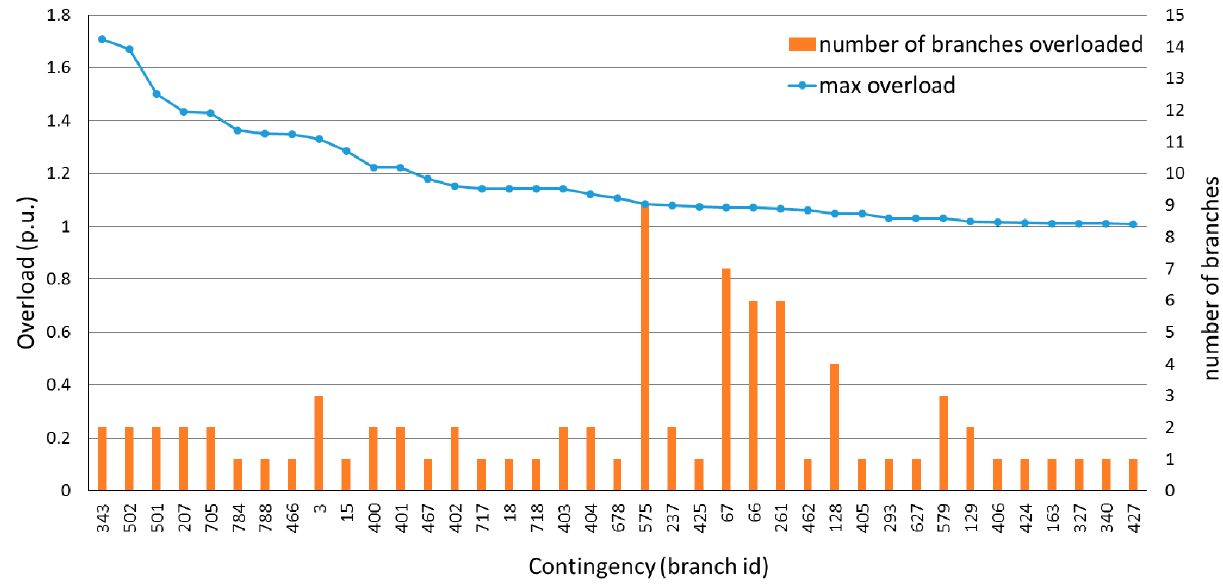
Figure 7. Number of overloaded branches due to each contingency able to cause branch overloads (contingencies are identified here by a branch id, which is the id of the branch disconnected, and correspond to the first 39 contingencies in Figure 6).